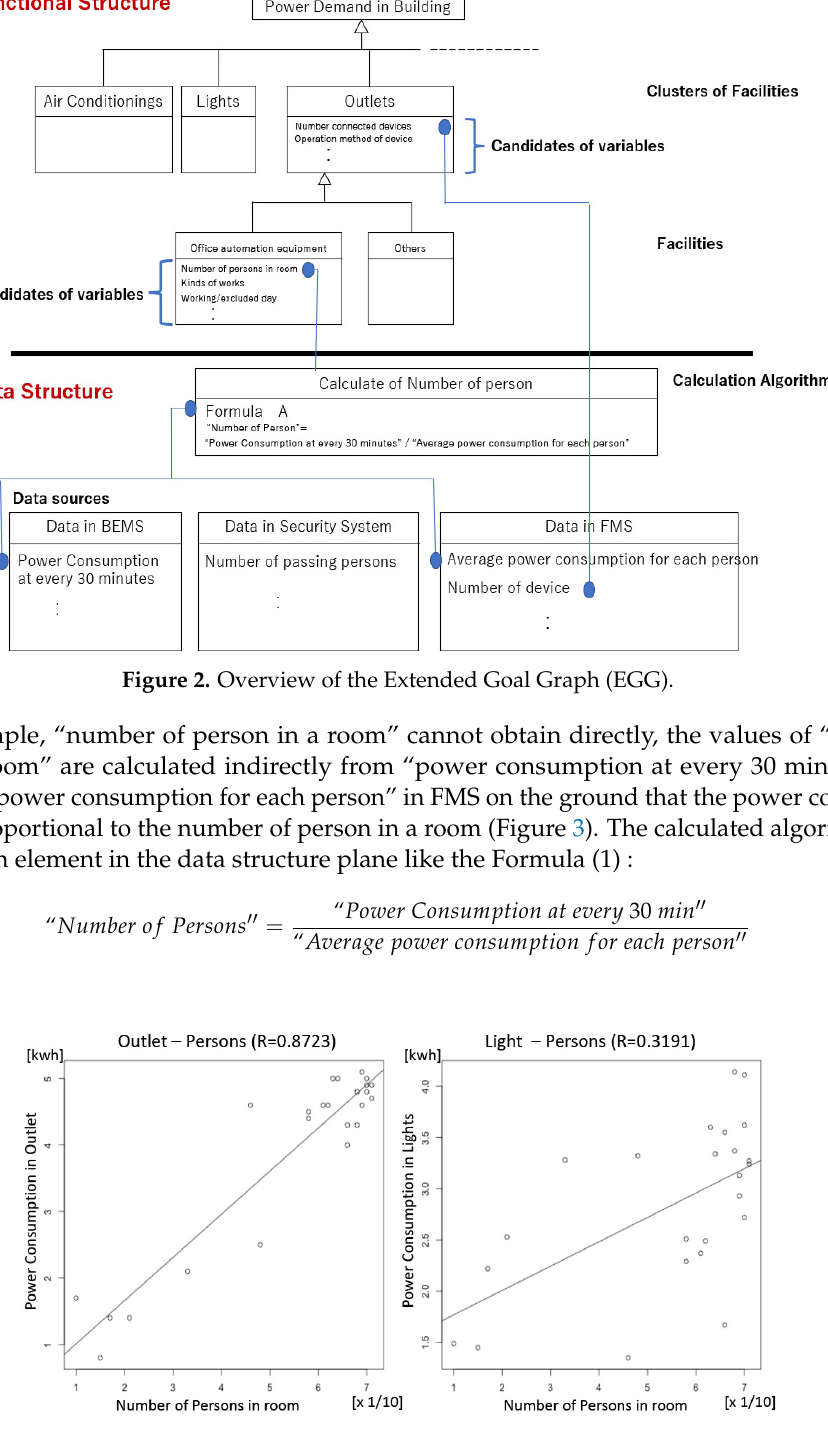
Figure 3. Relations among number of persons, power consumption in light and